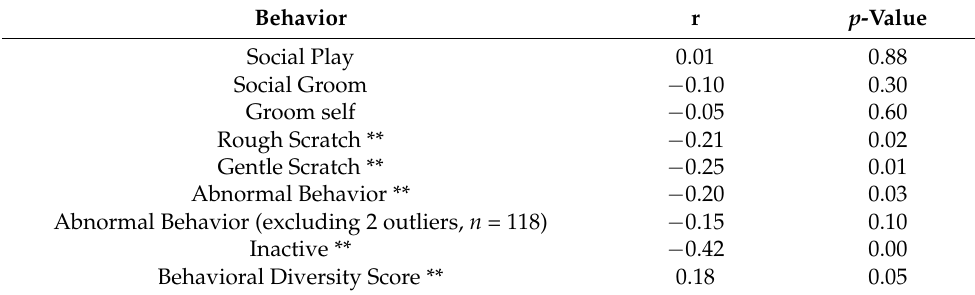
Figure 5. Mean percentage of time spent locomoting as a function of the experimental phase in the medication choice study. Error bars represent the standard error of the mean. The percentage of time spent locomoting was higher during the experimental phases of the paradigm, including the choice phase (during which chimpanzees received a choice between meloxicam and ibuprofen) compared to the baseline phase (prior to the start of the study) ( p ≤ 0.05). Table 2. Relationships between locomotion and welfare-related behaviors.